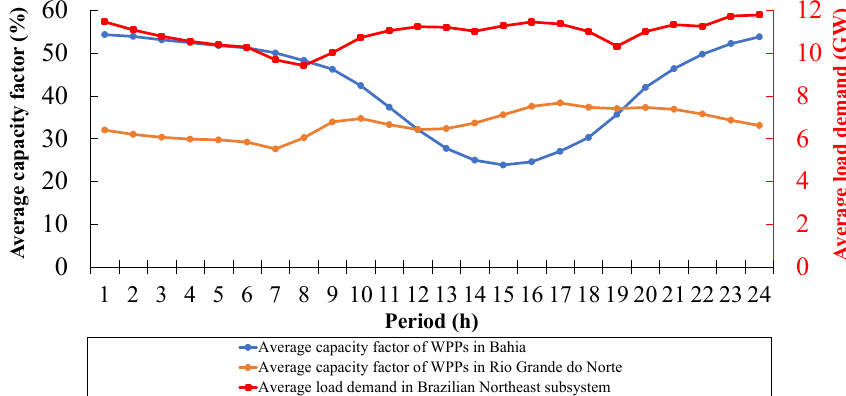
Figure 2. Average hourly capacity factor of wind power plants (WPPs) in states of Bahia (inland) and Rio Grande do Norte (coast), and daily profile of average load demand in the Brazilian northeast subsystem in 2019. Data source: